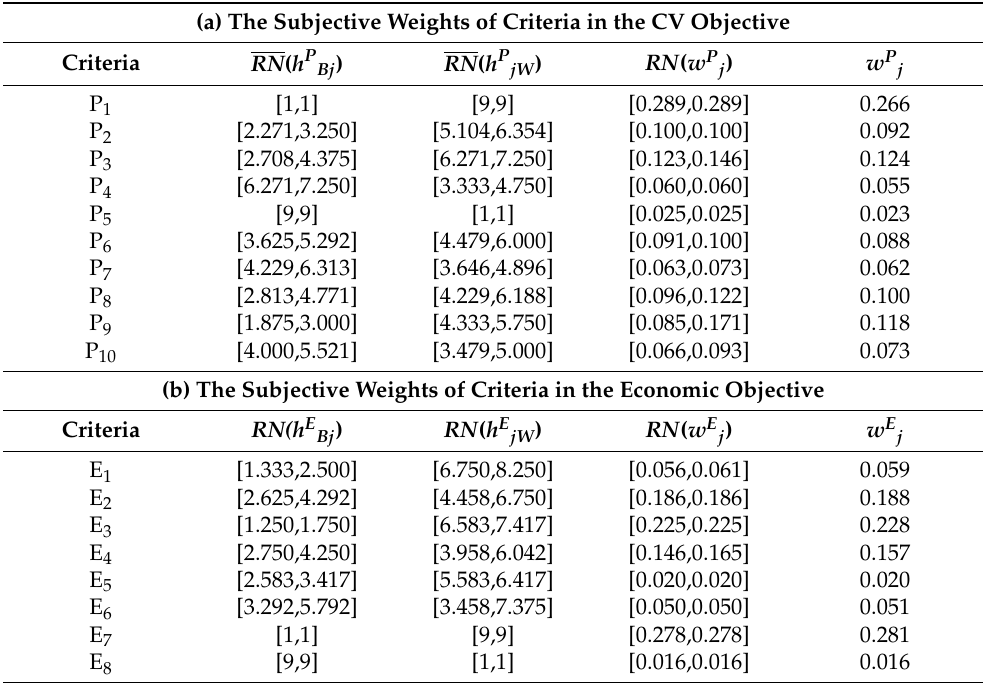
Table 7. The results of RN(h Bj ), RN ( h jW ) and weight w j of the criteria in CV and economic